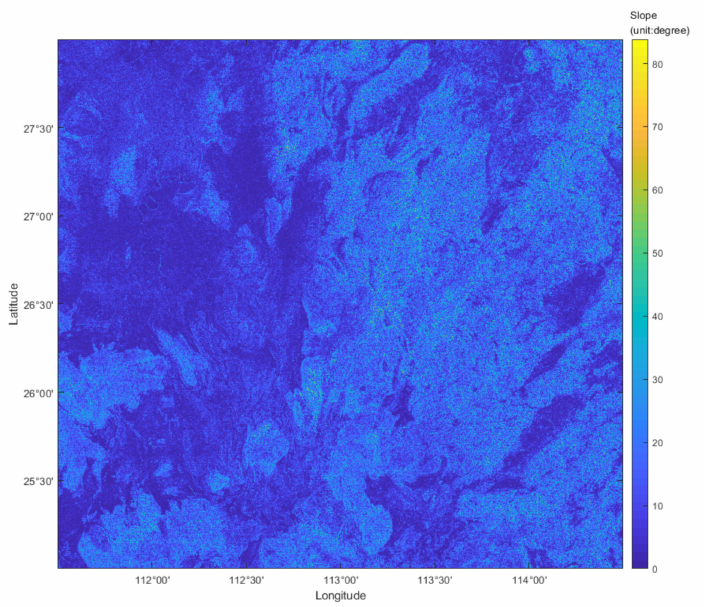
Figure 3. Slope map of study